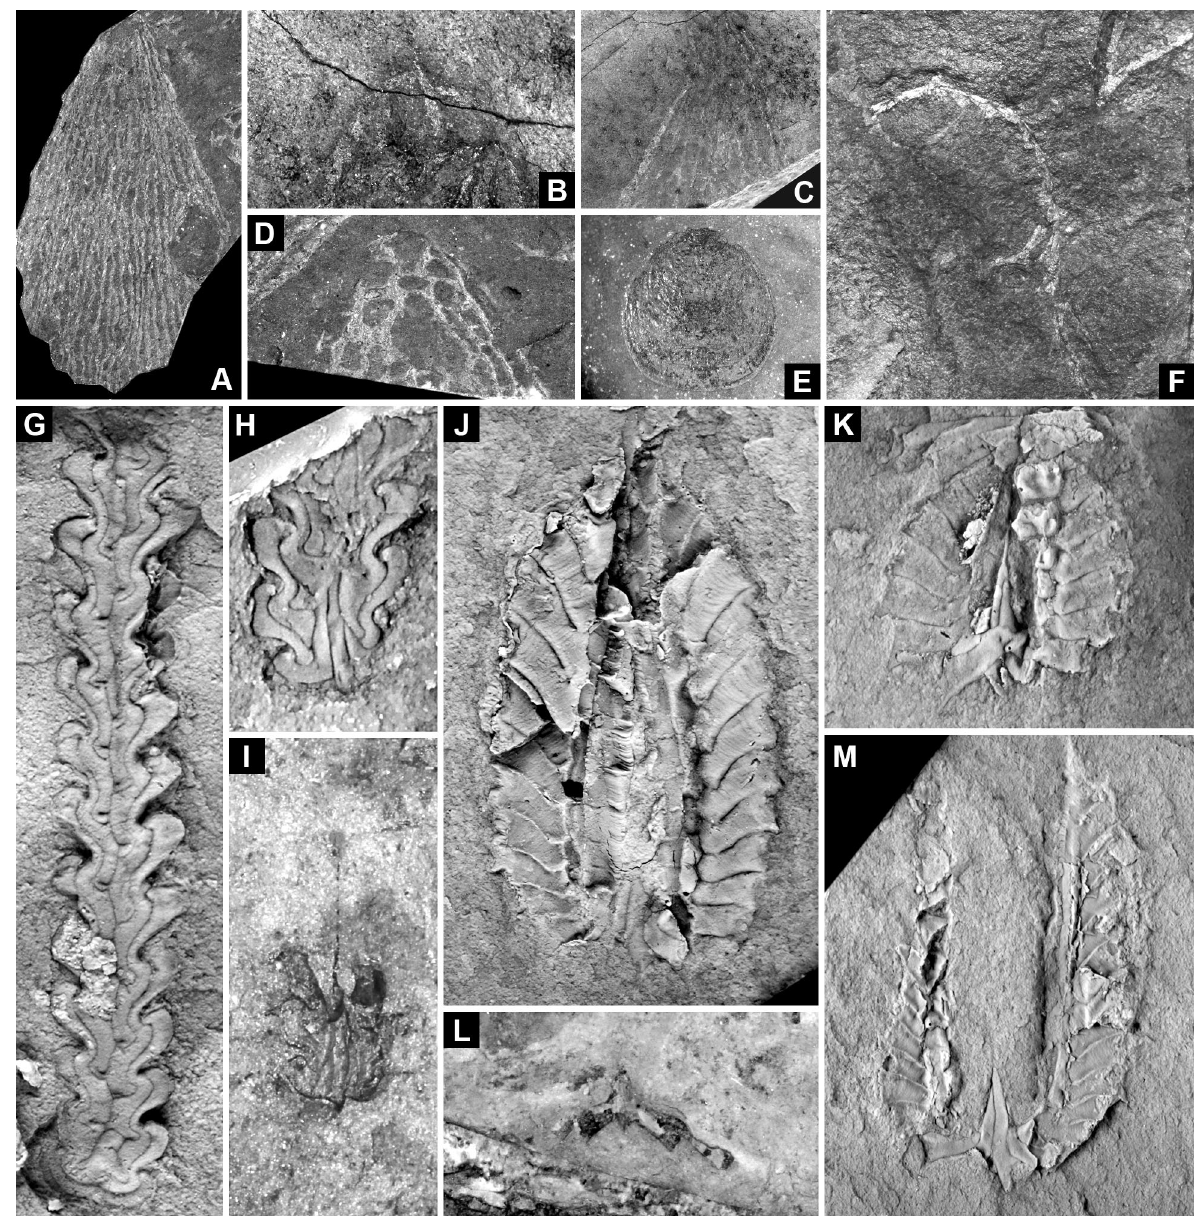
Fig. 2. Ordovician fossils from the Karadere and Inc(cid:252)ves sections, NW Anatolia. A (cid:150) D , Rhabdinopora flabelliformis (Eichwald) ssp.: A, fragment of a somewhat compressed rhabdosome; B, detail of a young colony showing sicula; C, flattened rhabdosome in lateral view; D, proximal fragment flattened obliquely to axis (A, D, Kar3-1 (cid:215) 1.5 and (cid:215) 3.7, respectively; B, C, Kar3-4 (cid:215) 5 and (cid:215) 1.2). E , dorsal valve of linguliform brachiopod (Kar4-b1, (cid:215) 2). F , Paradelograptus cf. antiquus (T. S. Hall), incomplete rhabdosome with reclined stipes of first-order and one second-order dichotomy (Kar4-2, (cid:215) 3.5). G , Levisograptus austrodentatus (Harris & Keble), latex cast of a pyritized rhabdosome in reverse view showing pattern U astogeny (Kar5-1, (cid:215) 12). H , I , Levisograptus sinicus (Mu & Lee), latex cast of a pyritized proximal region in obverse view (Kar5-1B/3, (cid:215) 17) and counterpart of a flattened immature colony in obverse view, with small nematularium and spiny thecal apertures (Kar5-1B, (cid:215) 13). J , K , Tetragraptus cor (Strandmark), latex casts of two pyritized specimens showing 1-2 stipe preservation in obverse view (J, Kar5-10, (cid:215) 8; K, Kar5-4, (cid:215) 15). L , flattened proximal end of declined didymograptid (Kar5-15, (cid:215) 8.3). M , Tetragraptus bigsbyi (J. Hall), latex cast of a pyritized specimen showing 1-2 preservation (Kar5-5/5, (cid:215) 6). The samples are reposited at METU Geology Museum (Repository No.